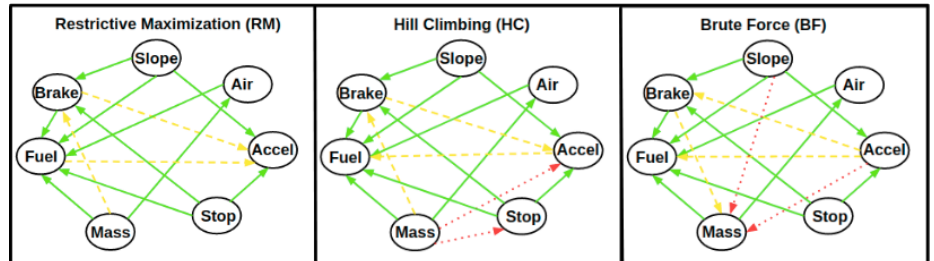
Figure 3. Bayes networks discovered by the algorithms (RM, HC, and BF) over the feature set accel (Accel), avg_slope (Slope), air_cond_ptime (Air), brake_usage (Brake), mass (Mass), fuel_per_km (Fuel), and stop_ptime (Stop). The set is described in Section 2.2. The green continuous arrows are common links (CL) between the networks, the yellow dashed arrows are common links with discordant directions (CLDD), and the red dotted arrows are uncommon links (UL), as presented in Table 2.